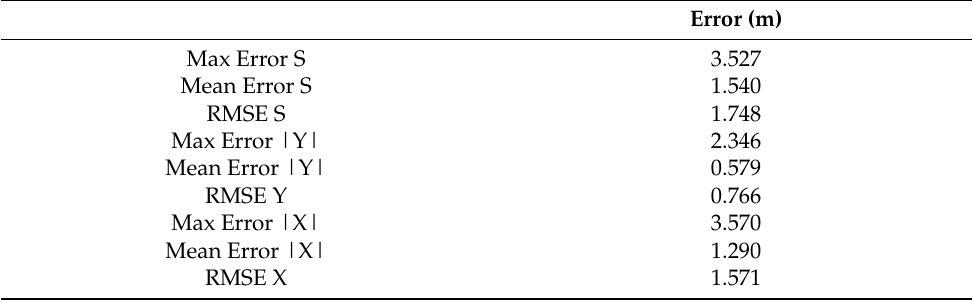
Table 4. Errors in positioning using anomaly detection and weighted LM algorithm.